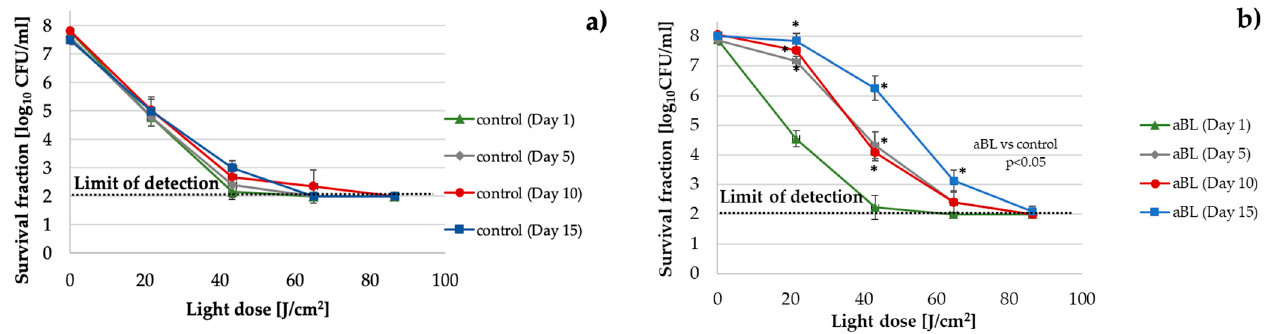
Figure 3. P. aeruginosa P14 aBL tolerance development upon exposure to sublethal aBL treatment. Overnight P. aeruginosa cultures (37 °C in LB for 16–20 h) were diluted to an OD of 0.5 McF, and 100-µL samples were irradiated with 415 nm light at a dose of 6.4 J/cm 2 (MDK 99 ). Following exposure, 10-µL aliquots of the treated samples were collected to determine the survival rate. A total of 50-µL of the sample was transferred into fresh LB medium (5 mL) to regrow overnight. The next day, after 16–20 h of incubation, the treatment was repeated under the same conditions. The cycle of exposure—regrowth— exposure was repeated 15 times. The potential reductions in the susceptibility of P. aeruginosa to aBL were examined after the 5th, 10th, and 15th consecutive cycles at higher doses of light (up to 86.4 J/cm 2 ) ( a ). The efficacy of aBL was also tested in samples from untreated controls (passaged daily without the selective pressure of aBL) ( b ). The detection limit was 100 CFU/mL. The values are the means of three separate experiments. The error bars represent the standard deviations (SDs). * All of the significant differences were estimated in comparison to the control from each day.